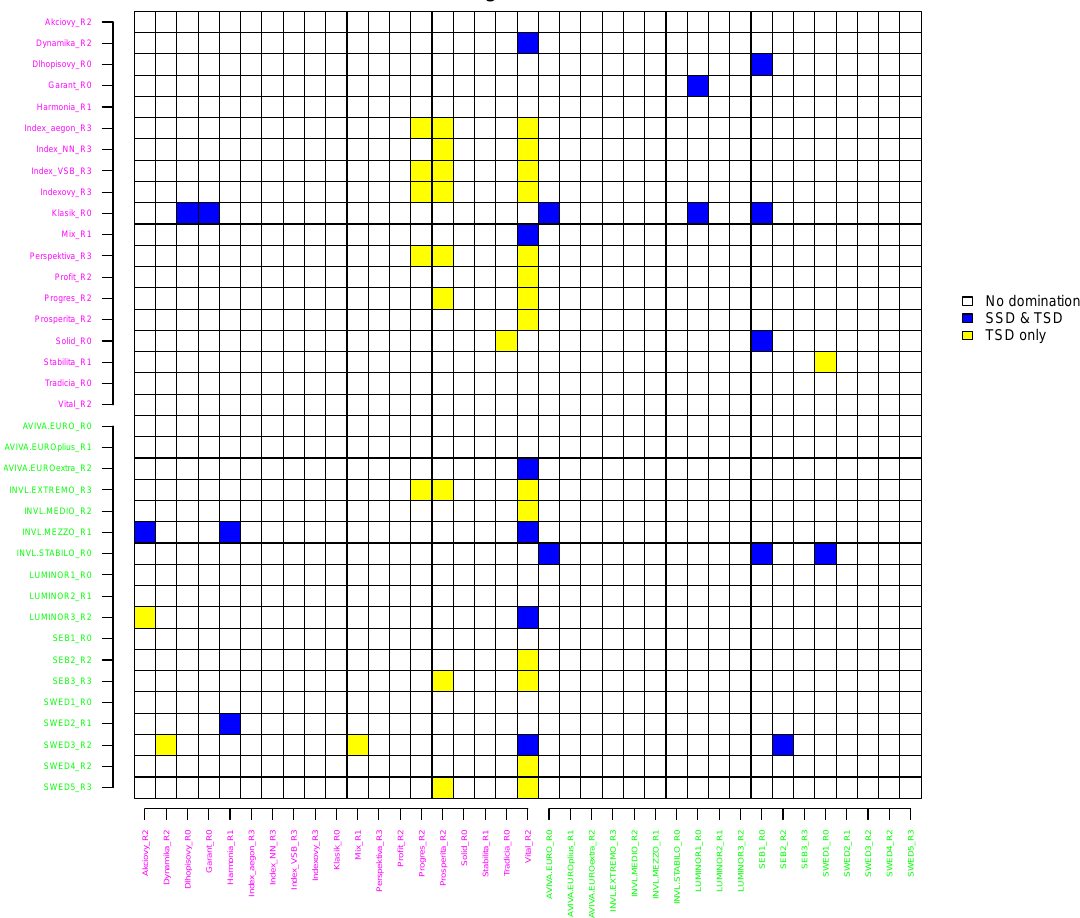
Figure 8. SD relations for all PFs assuming student- t